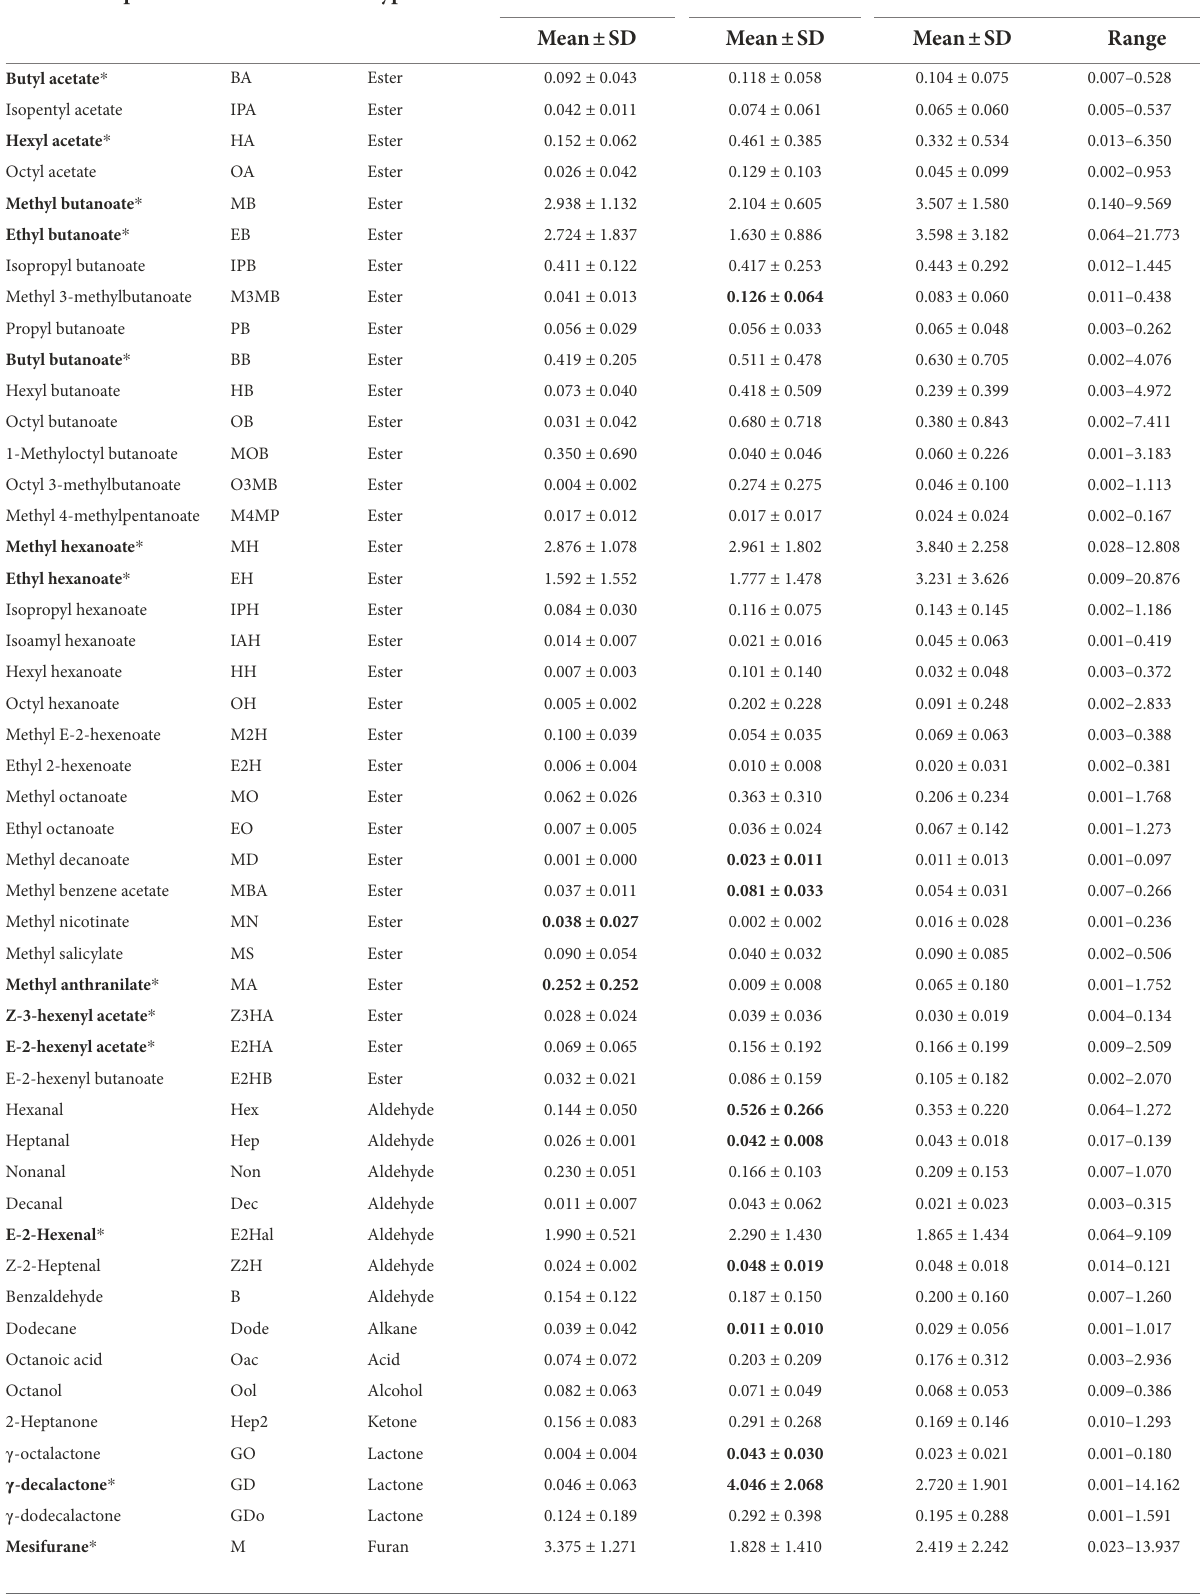
TABLE 1 VOCs summary in “FC50 × FD54”